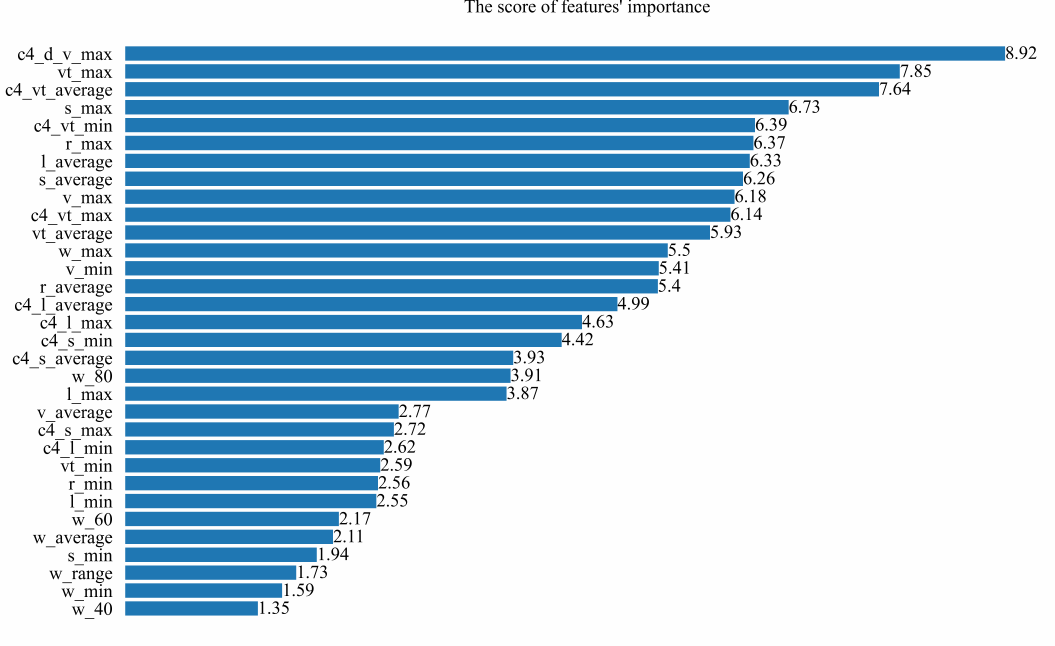
Figure 5. The score of features’ importance, top 20 essential features score greater than